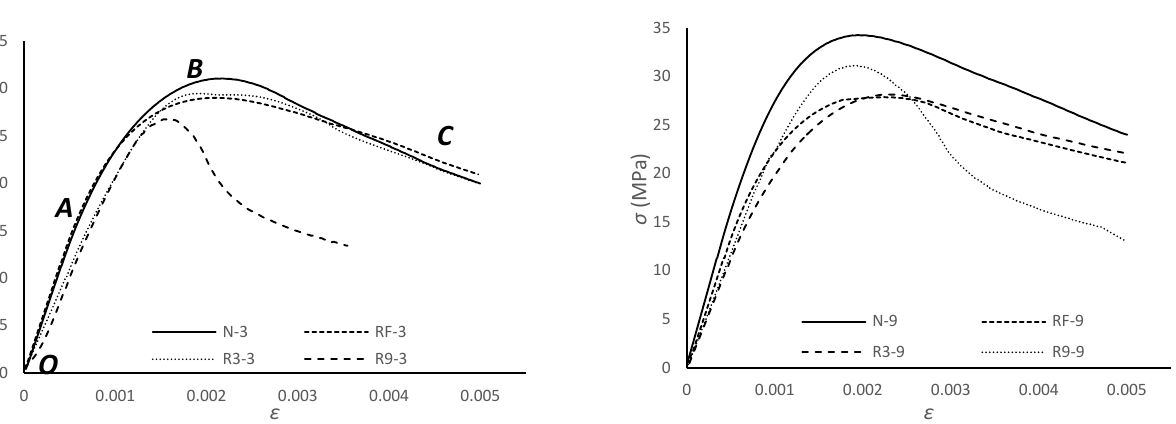
Figure 8. The elastic modulus results of the tested concrete.